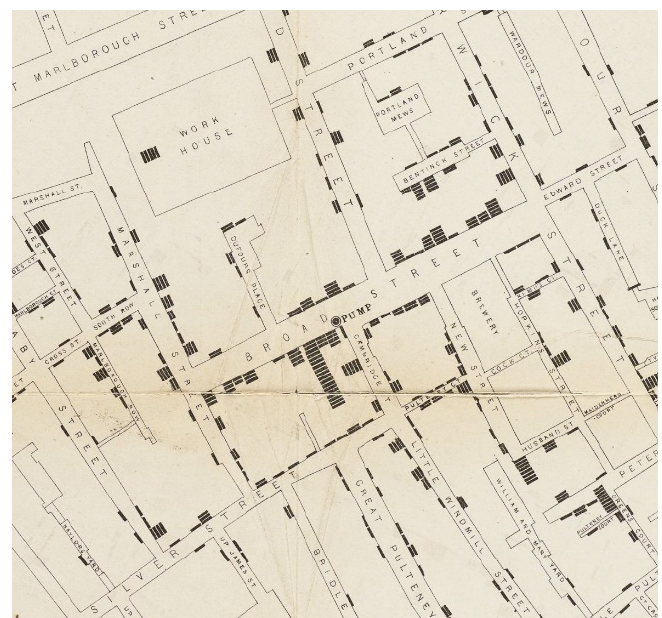
Figure 2. A map of Soho, London, created by John Snow to record the number of cholera deaths.